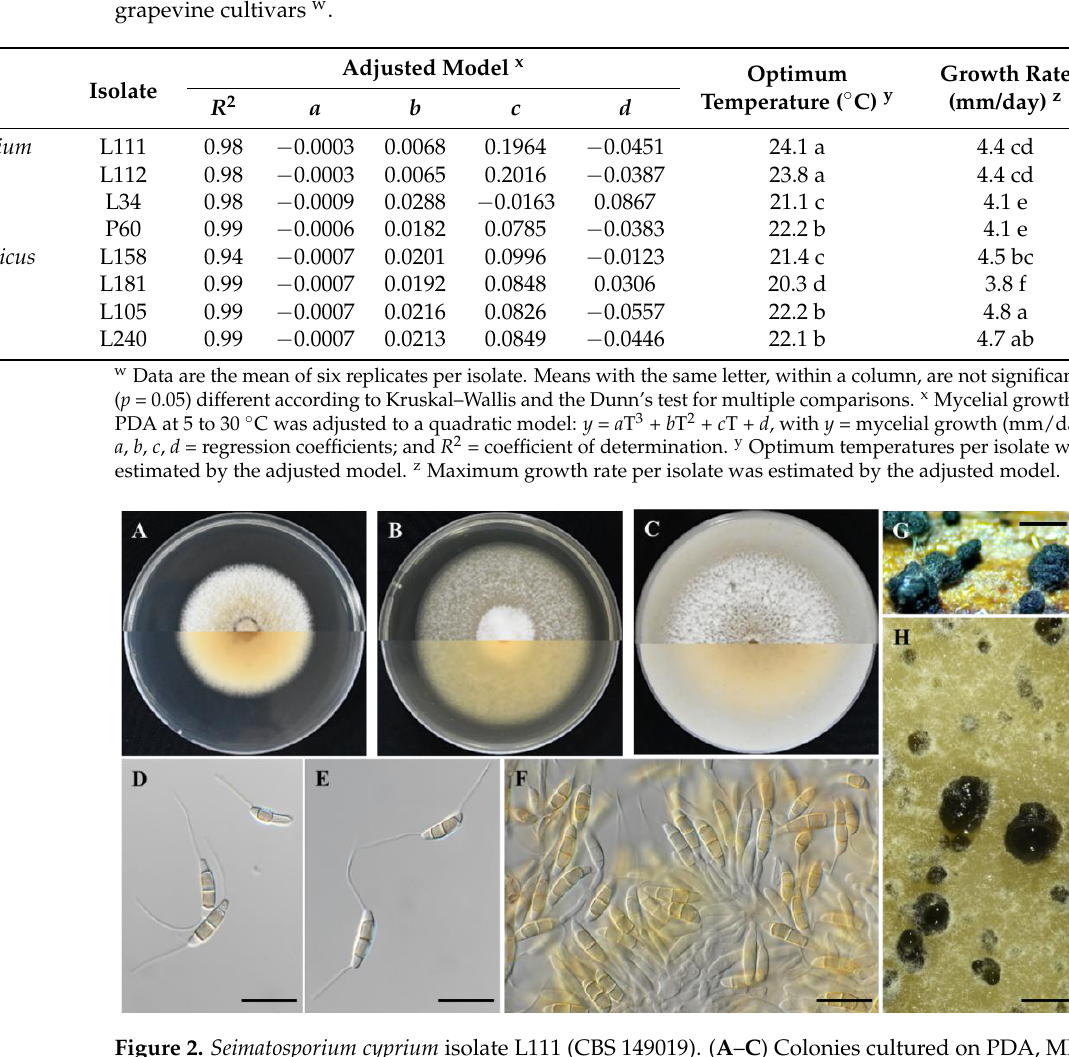
Figure 2. Seimatosporium cyprium isolate L111 (CBS 149019). ( A – C ) Colonies cultured on PDA, MEA and OA, respectively, at 25 °C in the dark for 14 days (top: above and bottom: reverse). ( D , E ) Septate conidia with long basal and apical appendages. ( E , F ) Conidiophores, conidiogenous cells and conidia. ( G ) Superficial conidiomata on autoclaved grapevine wood segments. ( H ) Conidiomata on OA. Scale bars: 20 μm ( D – F ) and 500 μm ( G , H ).